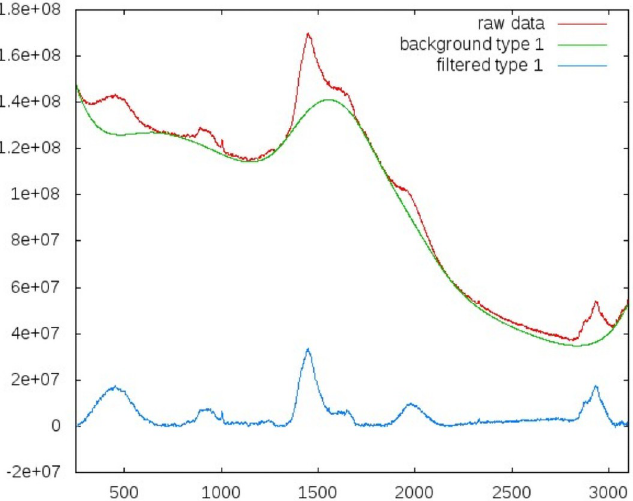
Fig 3. Background filtering with a more ‘rigid’ smoothing curve. Red indicates the original spectra, green the smoothing functions, blue the filtered data.